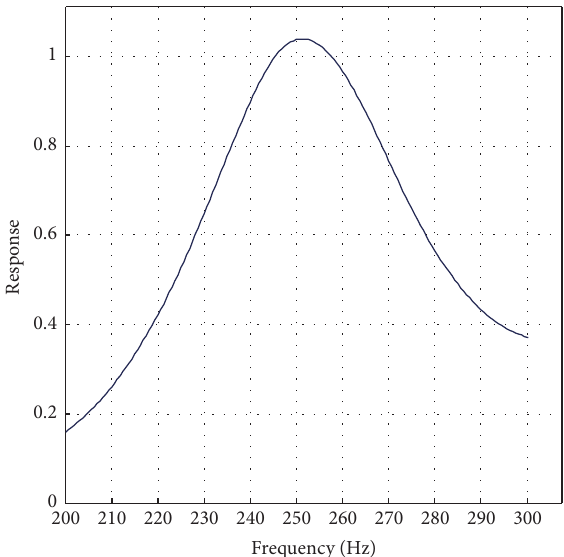
Figure 7: Finite element model of headstock with